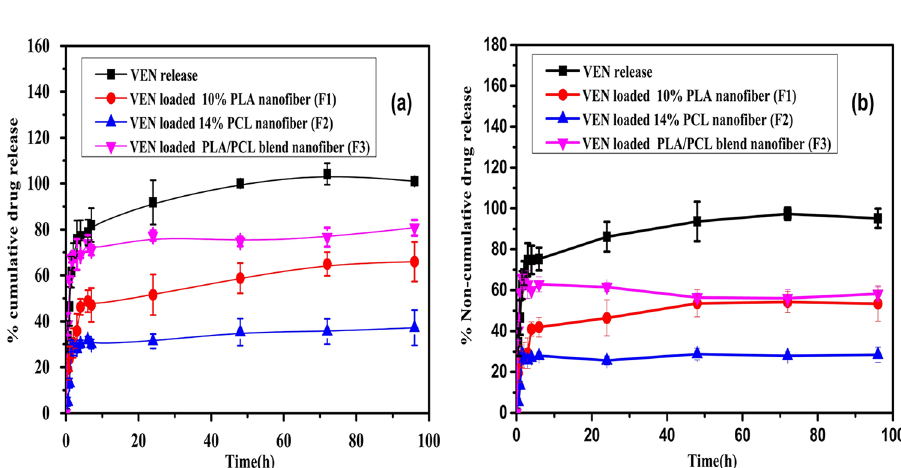
Figure 5. Drug release profiles of nanofibers for ( a ) cumulative, and ( b ) non-cumulative drug release amount in phosphate buffer (pH 7.4) at 37 °C and 100 rpm, data expressed as mean ± SD (n =